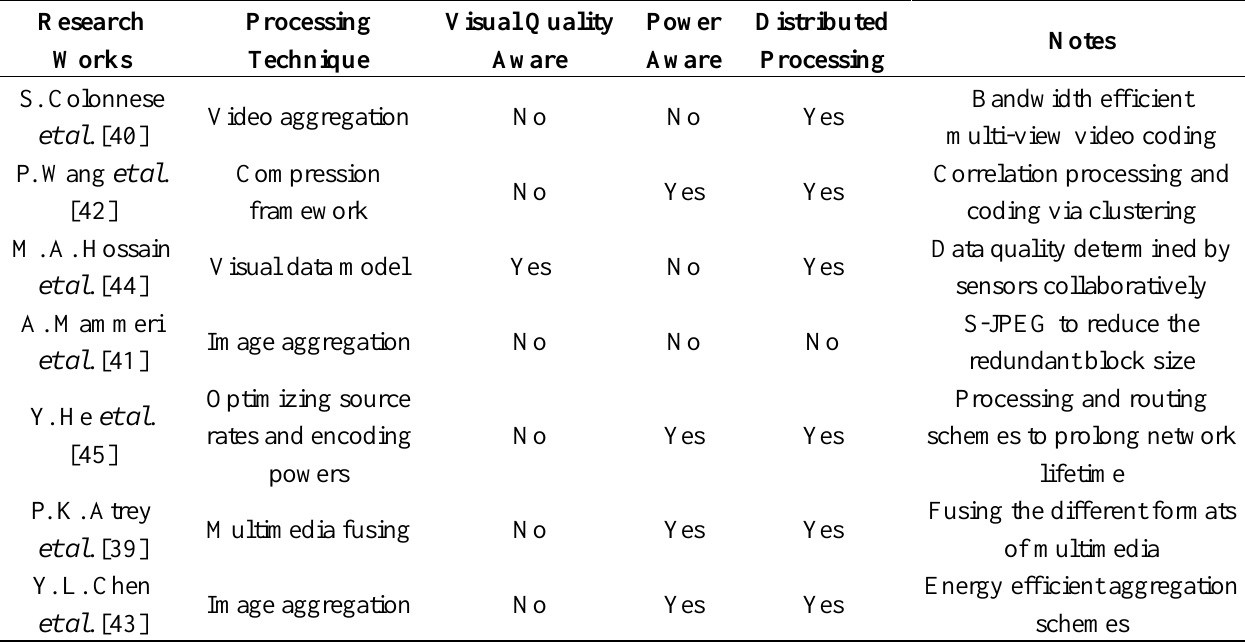
Table 4. Research works on data processing in